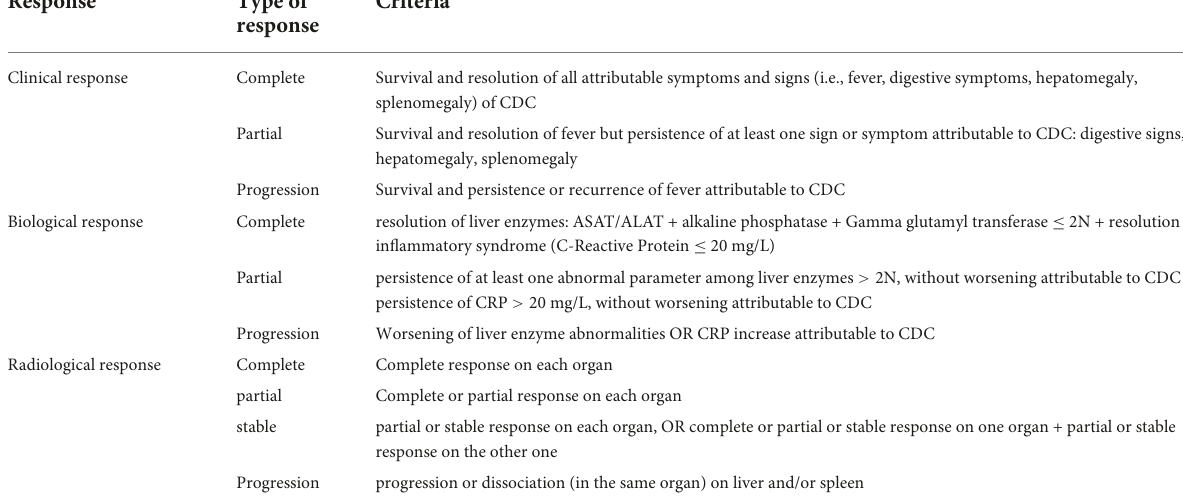
TABLE 1 Adapted criteria for chronic disseminated candidiasis (CDC)